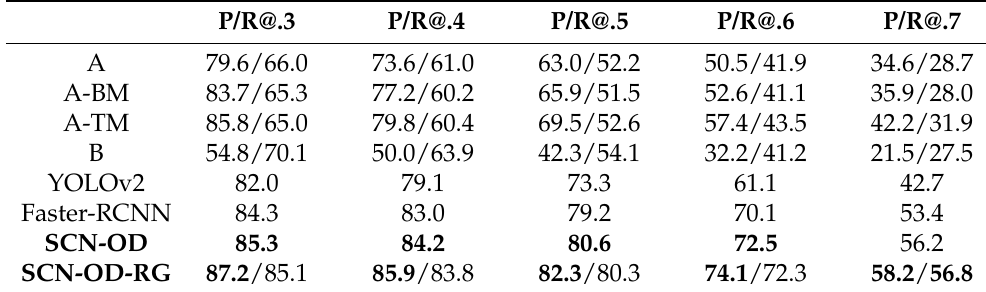
Table 2. Results for individual tree detection, measured by the precision and recall for different IoU thresholds in